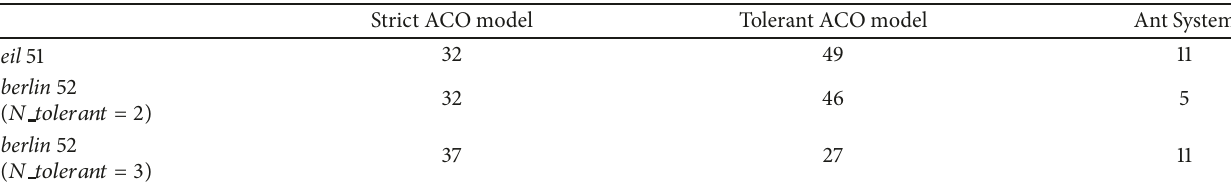
Table 2: The number of trials of the shortest tour of each model. Here, we focus on the tours in which all time-constrained cities are visited within limited time duration. One hundred trials are